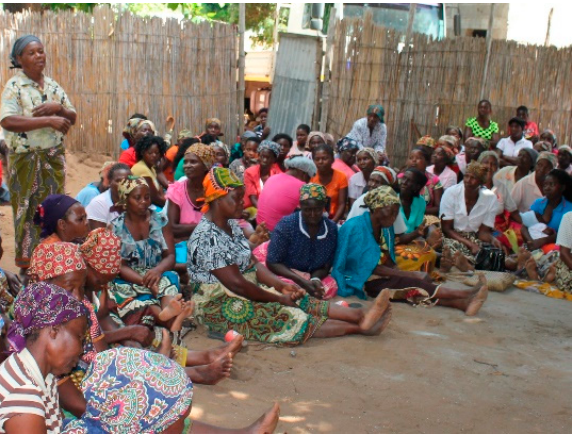
Figure 4. Meeting with women separately to ensure they understand their rights.